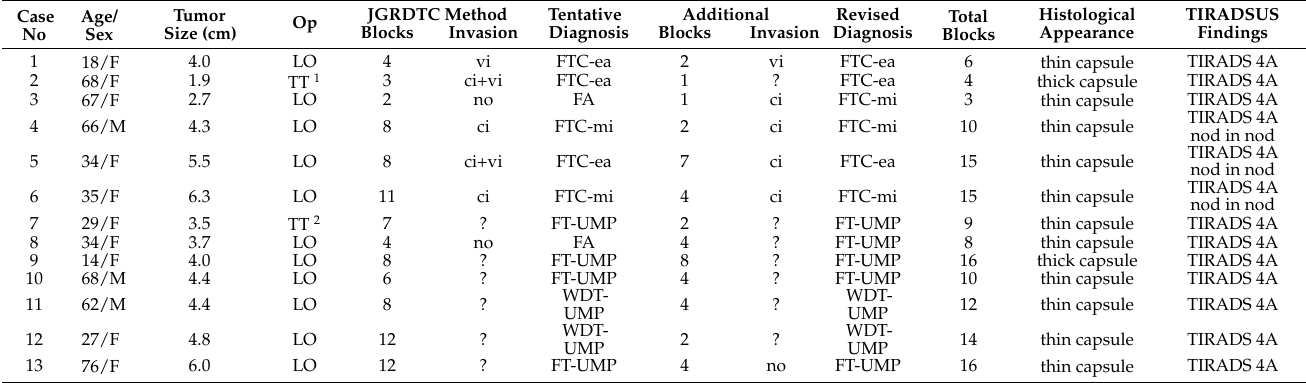
Table 6. Clinicopathological characteristics of 13 patients with FTC and